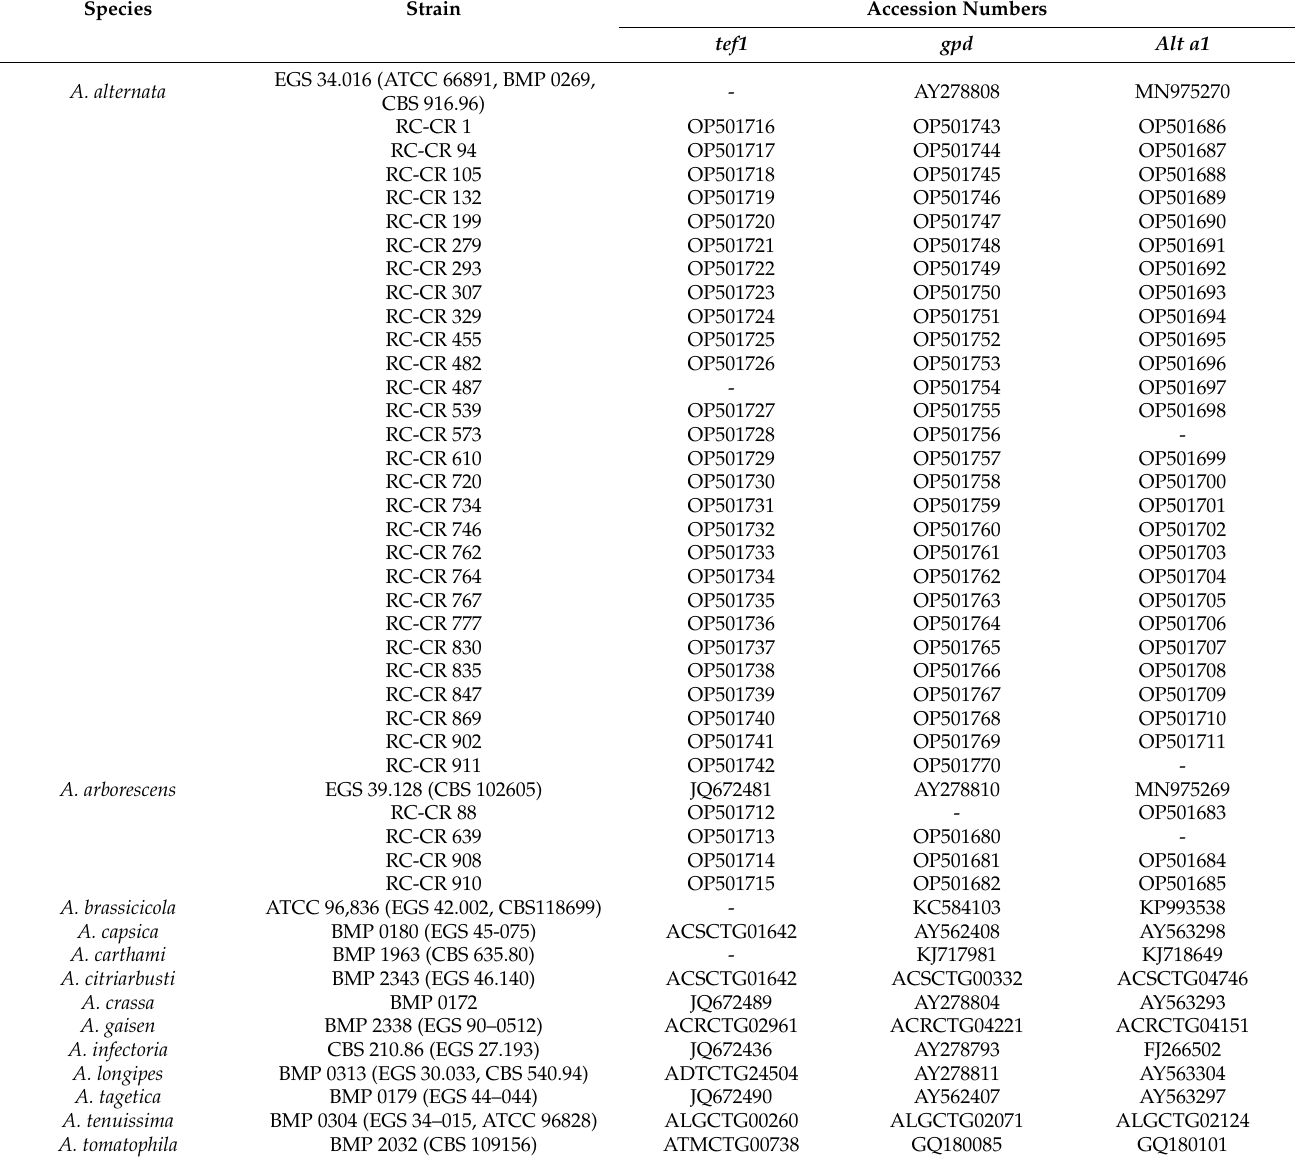
Table 1. Source information of Alternaria strains used in the phylogenetic